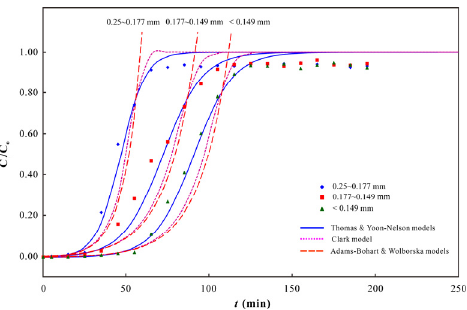
Figure 9. Effect of adsorbent grain size on breakthrough curve of PC ‐ Fe/C ‐ B adsorption As(V).